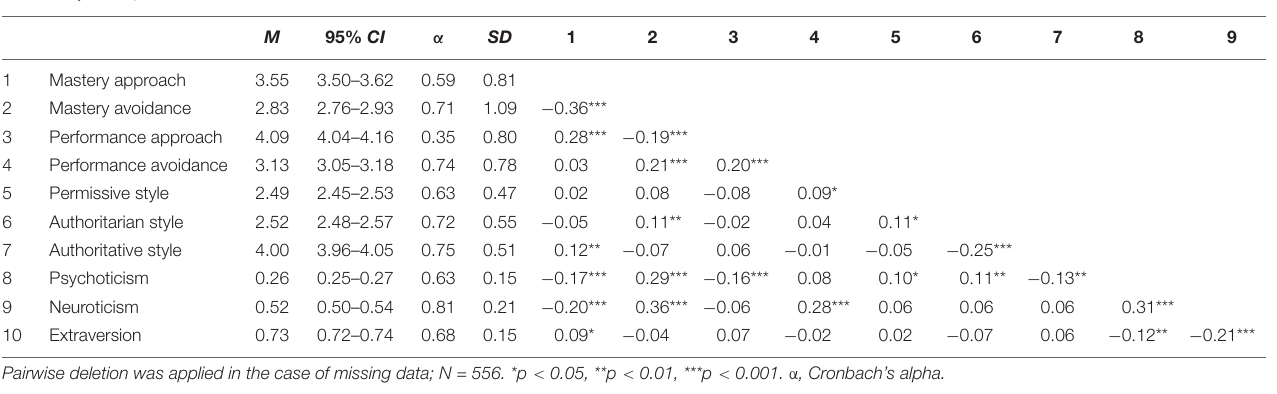
TABLE 1 | Descriptive statistics and Pearson’s correlation matrix.